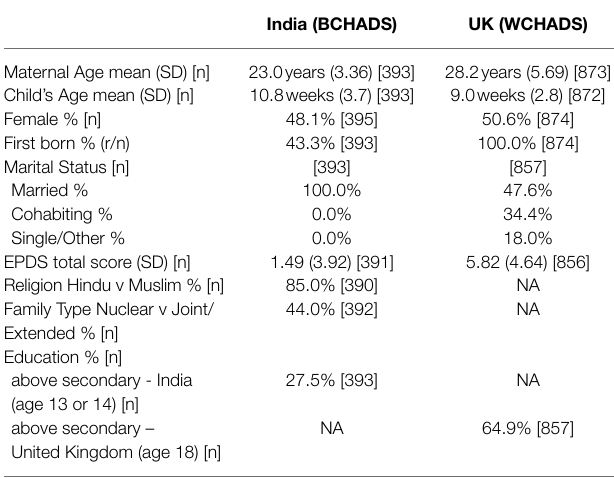
TABLE 1 | Demographic characteristics for those with a PICTS assessment in United Kingdom and